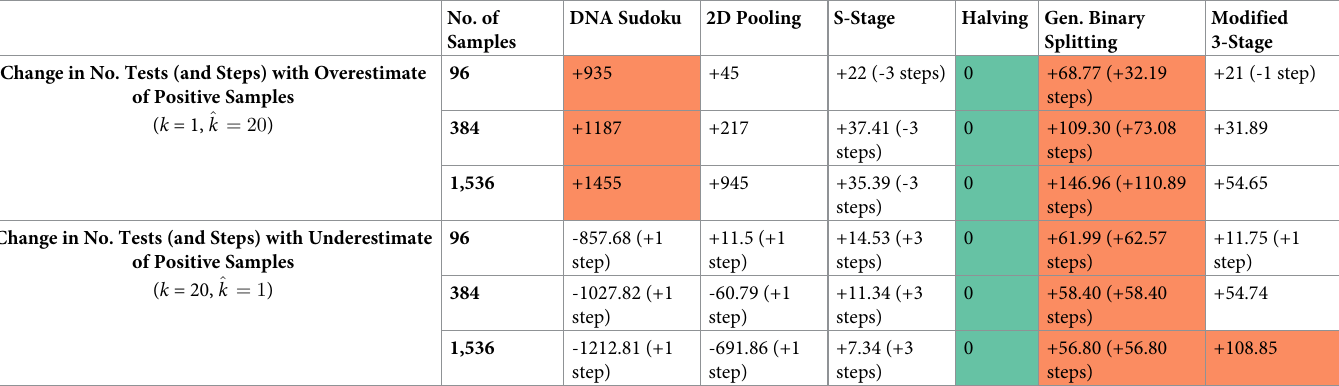
Table 6. The robustness of each pooling method to over- and underestimation of the number of positive samples.